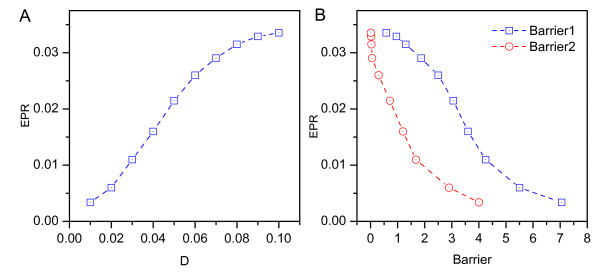
EPR. A:The diffusion coefficient D versus the entropy production rate. B:The barrier height Barrier1 = Ufix - Umin and Barrier2 = Ufix - Umax versus the entropy production rate.